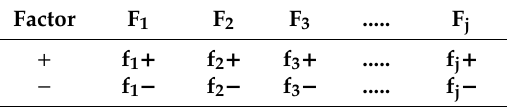
Table 1. Factorial study